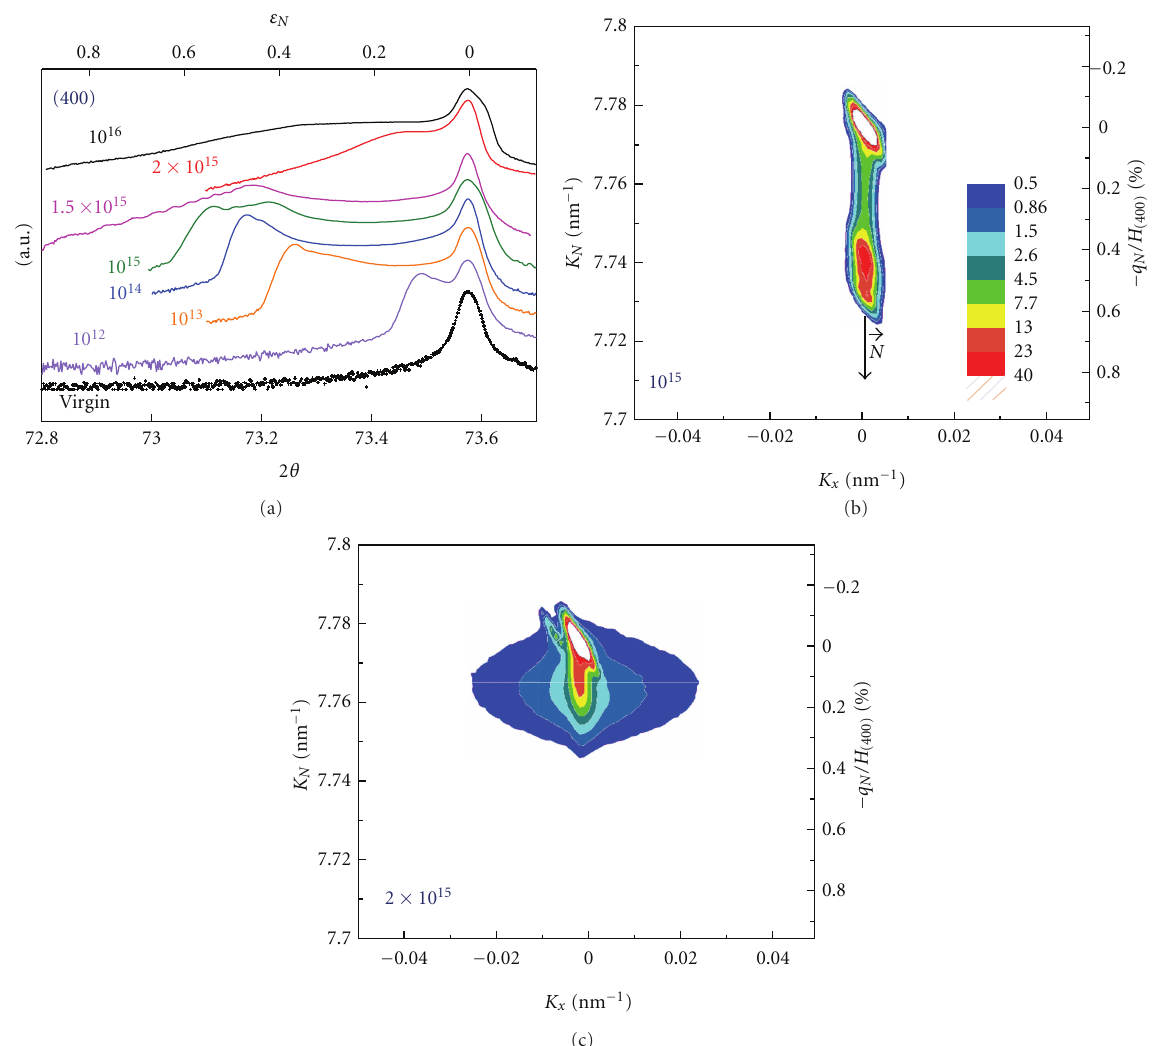
Figure 3: (a) θ -2 θ scans recorded around the (400) reflection of cubic zirconia crystals irradiated at RT with 4-MeV Au ions. Note that the intensity is also displayed as a function of the normalized deviations from the reciprocal lattice vector ( − q N /H (400) ) , which is equal to the elastic strain in the direction normal to the surface sample. ((b)-(c)) Reciprocal space maps in the vicinity of the (400) Bragg reflection for cubic zirconia irradiated at RT with 4-MeV Au ions at 10 15 cm − 2 (b) and 2 × 10 15 cm − 2